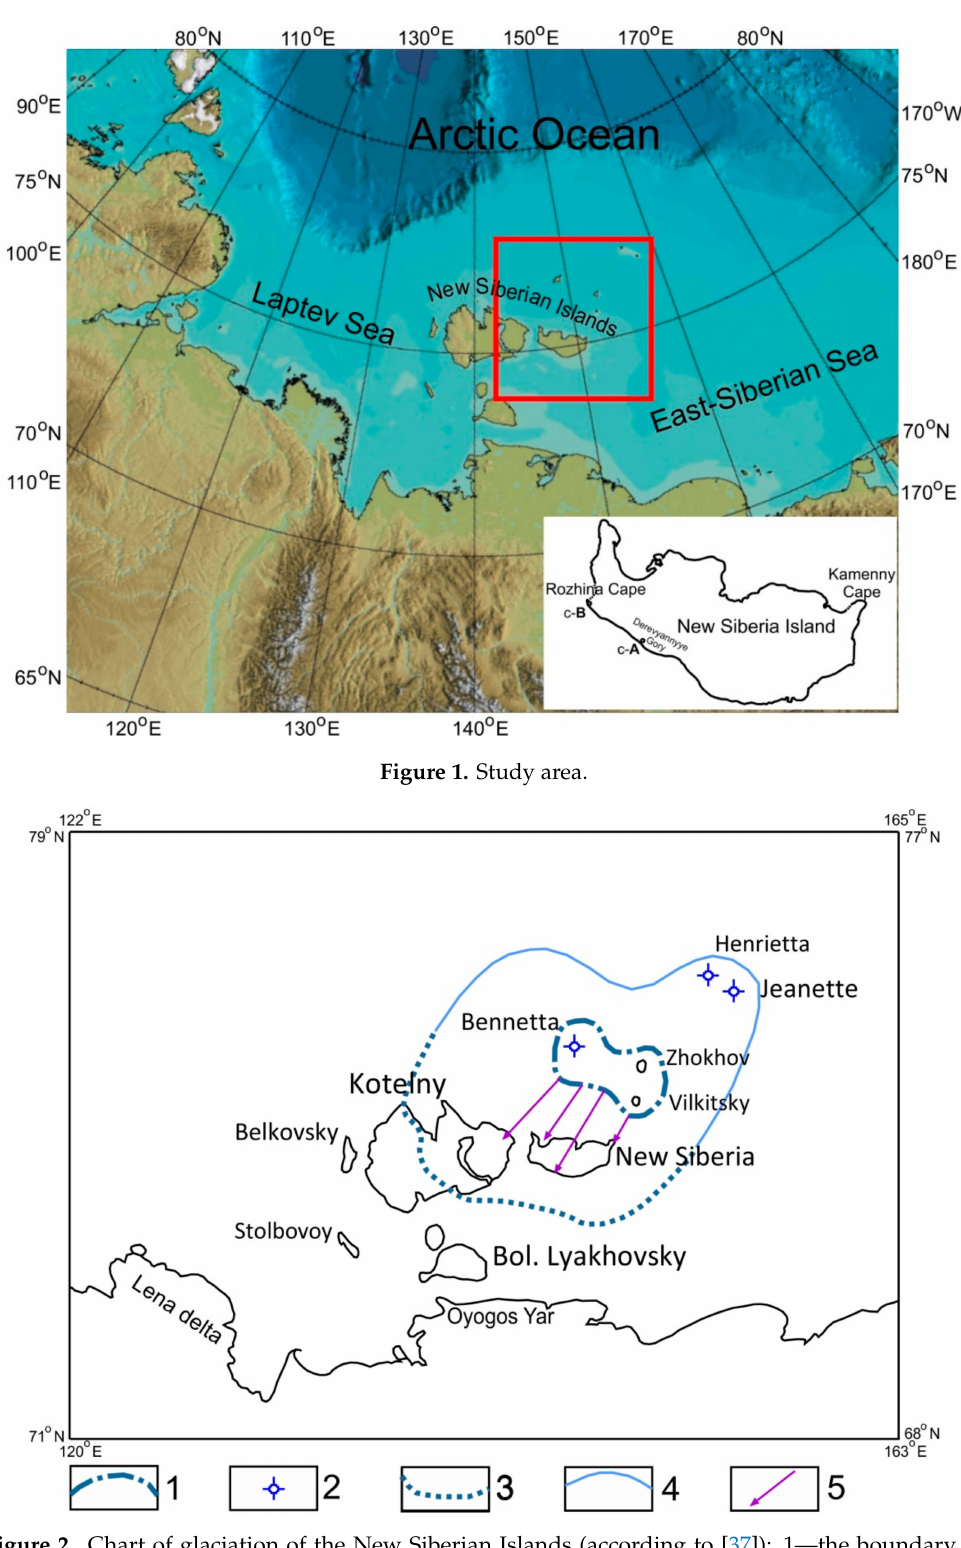
Figure 2. Chart of glaciation of the New Siberian Islands (according to [37]): 1—the boundary of the supposed center of the Middle Neopleistocene glaciation; 2—the position of the modern glaciers; 3—the southern boundary of expansion of the Middle Neopleistocene glacier; 4—the northern boundary of the possible glacier expansion; 5—established directions of glacier